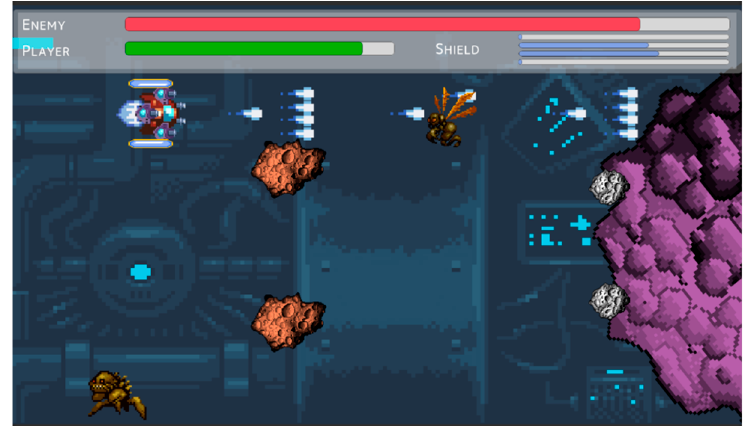
Figure A3. Game interface for the final mission with the spaceship and different tokens deployed.